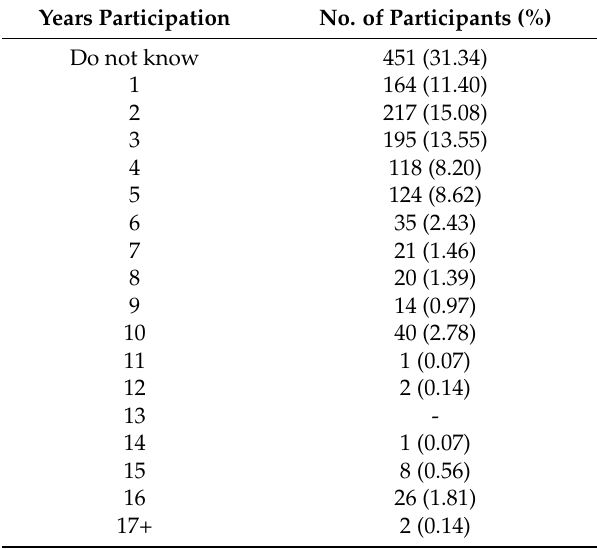
Table 2. Distribution of participants by number of years in mass drug administration (MDA) participation.